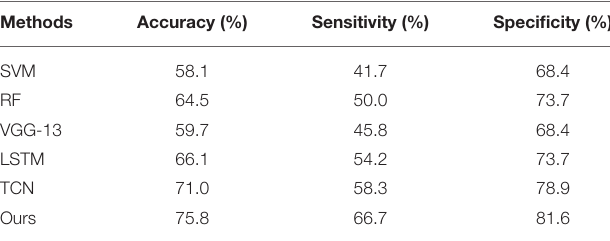
TABLE 3 | Comparison between TCN-ResNet18 and other methods, where Ours refers to TCN-ResNet18. Methods